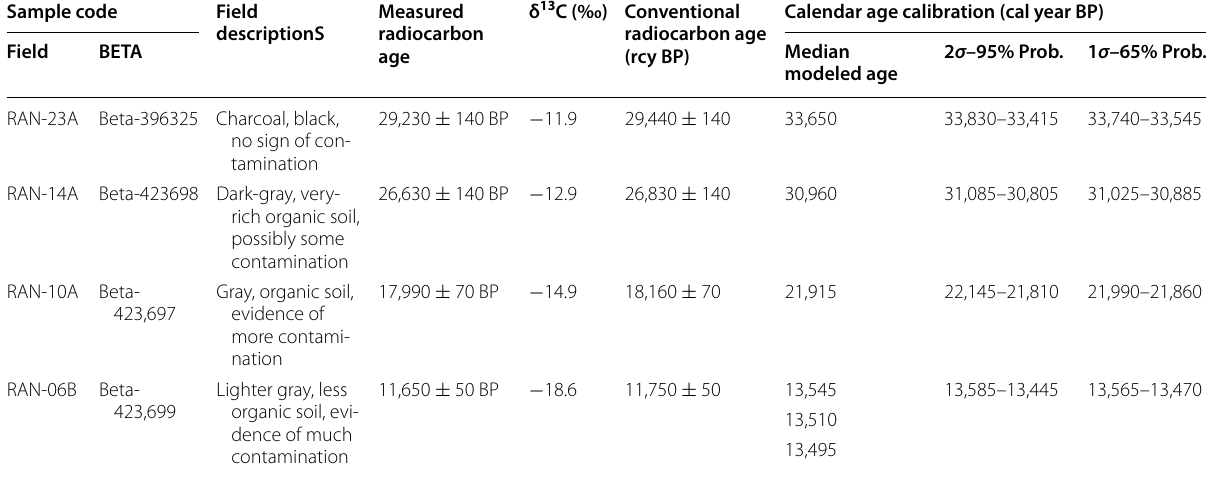
The calibration used mathematical approach developed by Talma and Vogel (1993) with reference to SHCAL 13 database (Hogg et al.